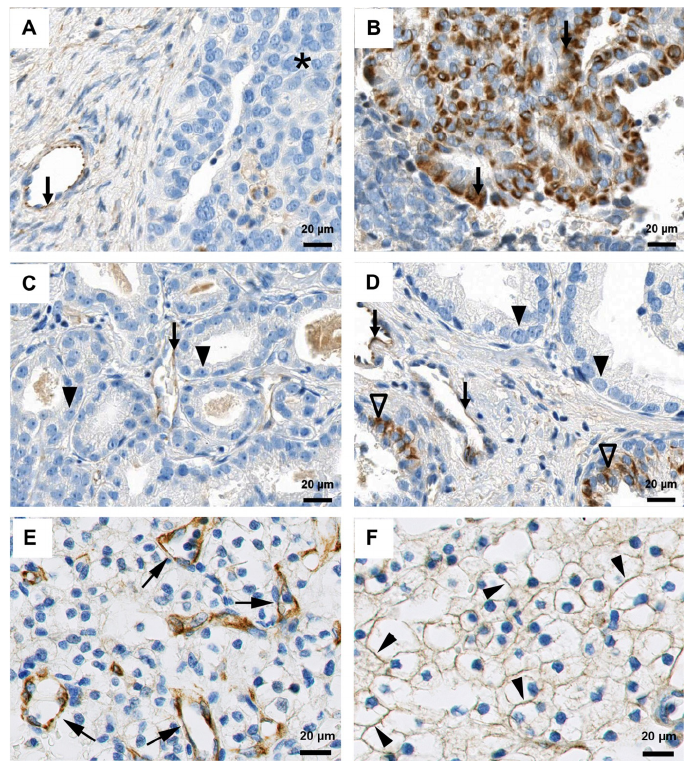
Figure 7. FSHR expression in human cancer detected with FSHR323 antibody. ( A ) and ( B ): Human ovarian cancer tissue. ( A ): No anti ‐ FSHR staining of tumor cells (asterisk) was observed in 78% of patients. A weak to moderate cytoplasmic staining of small blood vessels was detected (arrows). ( B ): Sample exhibiting a strong cytoplasmic anti ‐ FSHR staining of tumor cells (arrows). ( C ) and ( D ): Human prostate cancer tissue of Gleason grade of 3. ( C ): Sample exhibiting no anti ‐ FSHR staining in tumor cells (arrowheads), but a weak cytoplasmic staining of small vessels in the tumor stroma (arrows). ( D ): No anti ‐ FSHR staining of tumor cells was observed (arrowheads). A weak to moderate cytoplasmic staining of small vessels in the tumor and the peripheral stroma was noticed (arrows). Some of the tumor-adjacent hyperplastic prostate gland epithelial cells showed a strong cytoplasmic anti-FSHR staining (open arrowheads). ( E ) and ( F ): Human kidney cancer tissue. Arrows point to FSHR-positive blood vessels. Arrowheads indicate a moderate membrane staining of renal cancer cells.